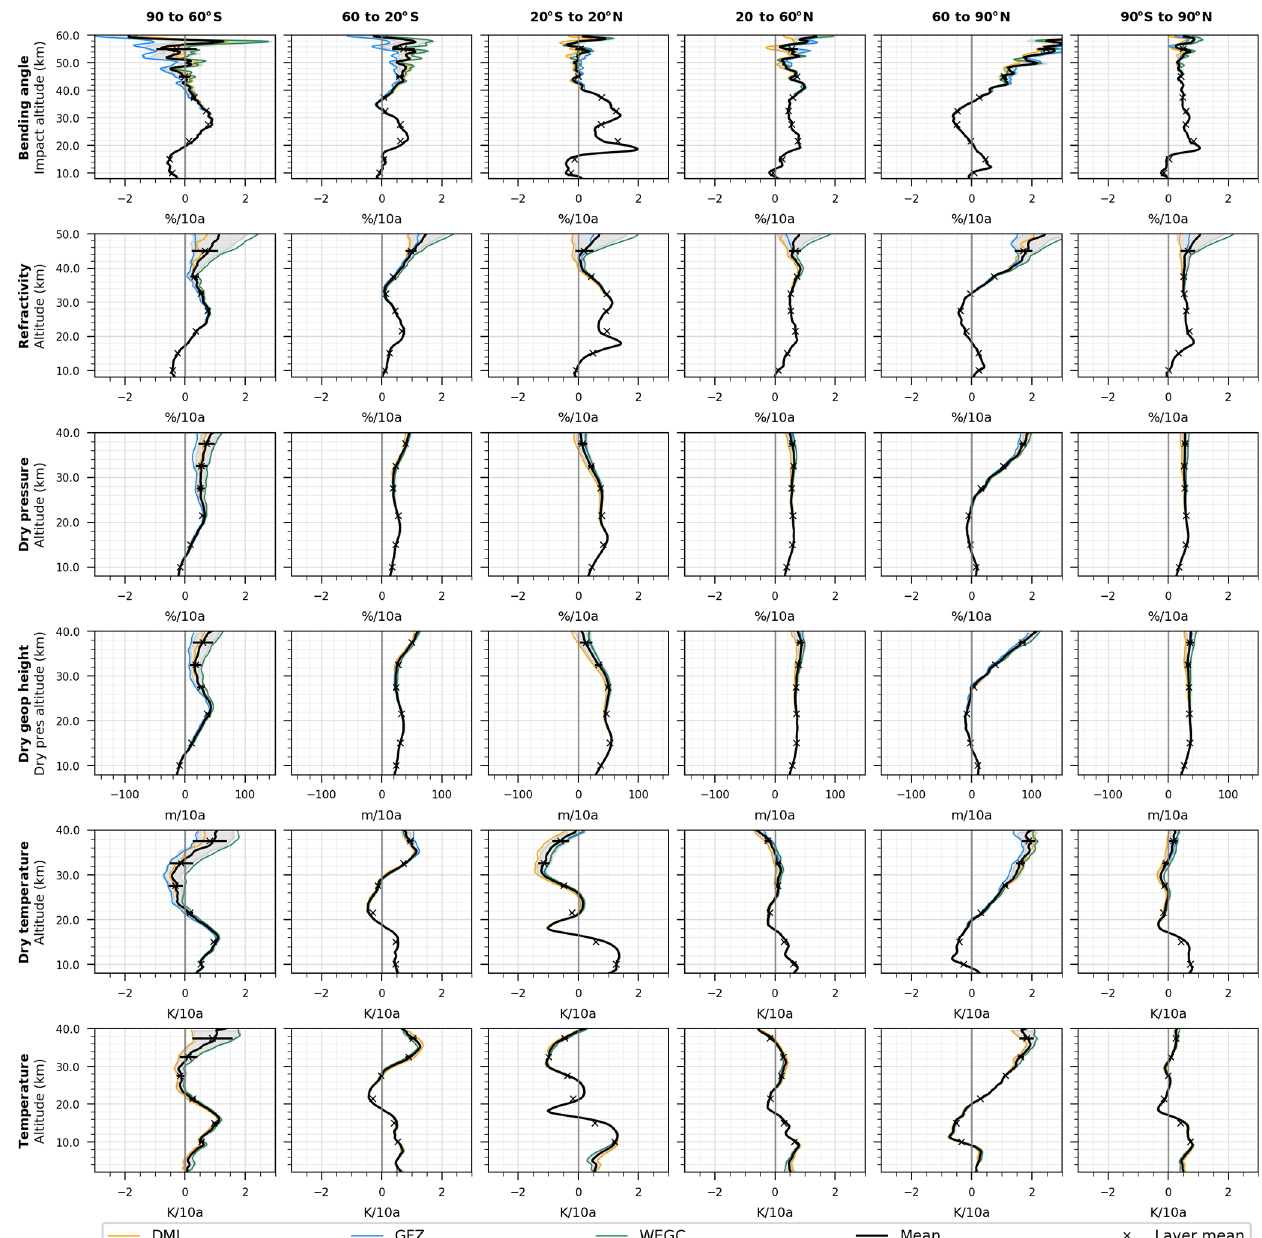
Figure 10. GRACE structural uncertainty indicated as the standard deviation (gray) of the individual center trends per decade based on 10 ◦ zonal medians for DMI (orange), GFZ (blue), and WEGC (green); shown for bending angle, refractivity, dry pressure, dry geopotential height, dry temperature, and temperature (top to bottom). The all-center mean trend profile (bold black line) and the altitude-layer mean trends (crosses, with horizontal bars showing the uncertainty) are indicated. Profiles are smoothed with a 1km running